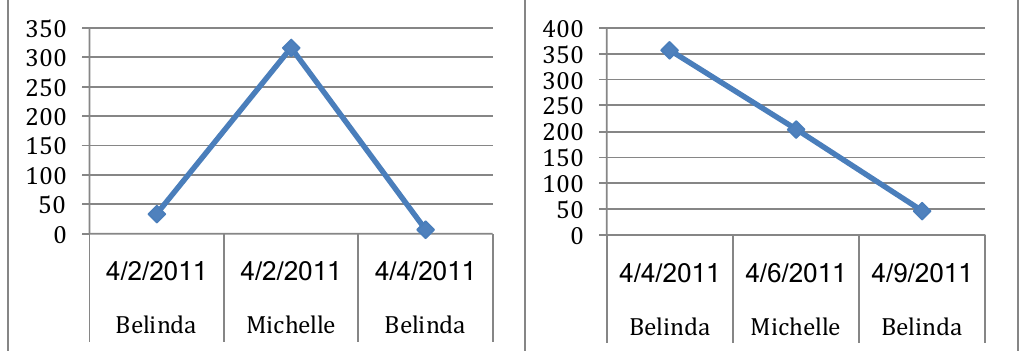
Evolution of the colors (left) and games (right) topics by word